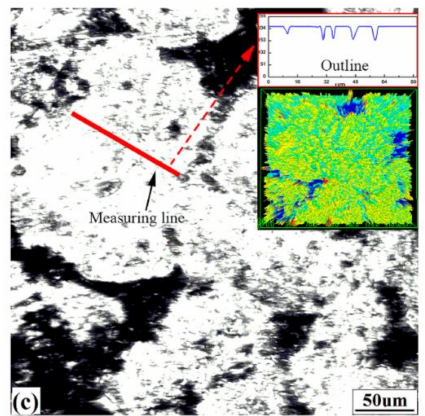
Figure 7. Surface morphology obtained by CSLM: ( a ) S1, ( b ) S2, ( c ) S3. The insets are corresponding magnified outlines and 3D confocal images.